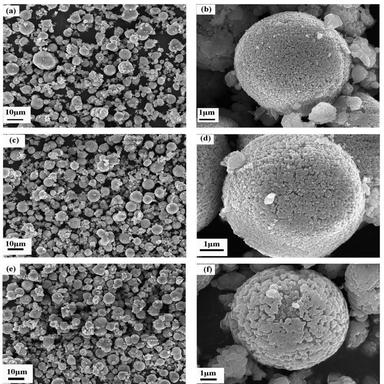
SEM images of s900, s1000 and s1100 samples.